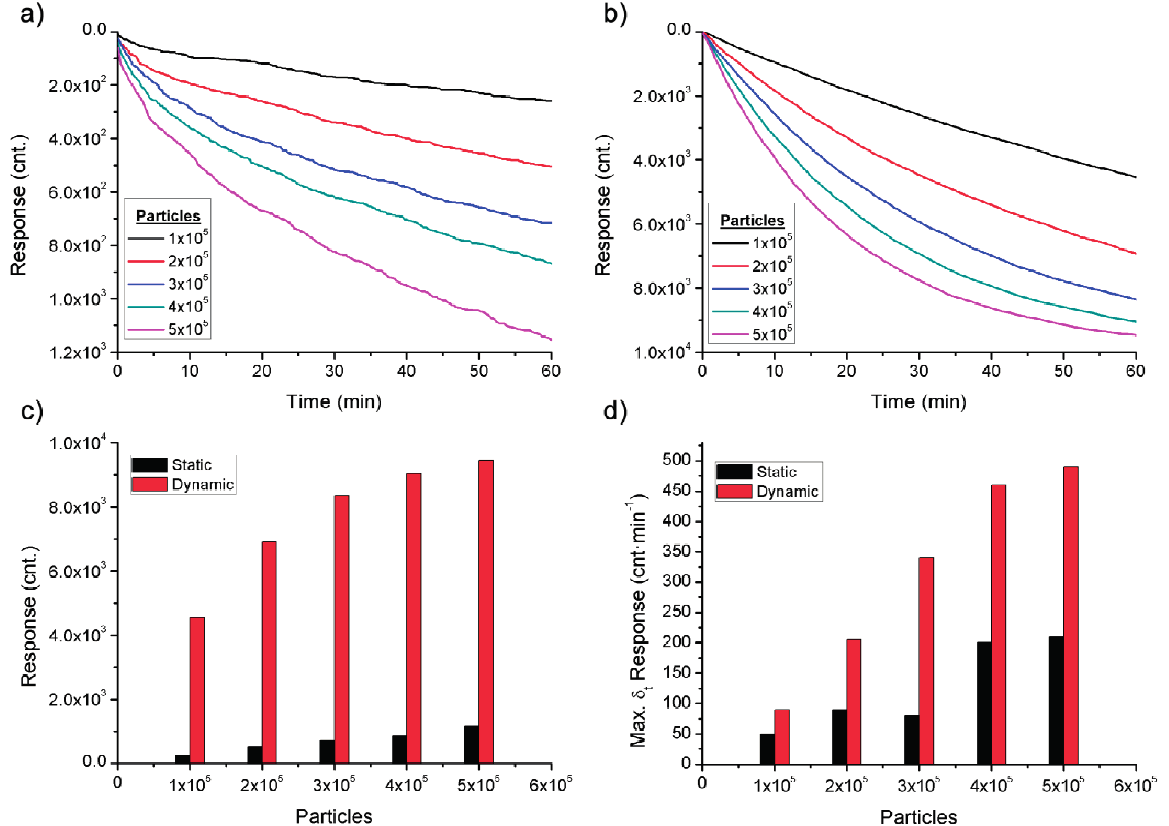
Figure 2. Simulation of ( a ) detection in static mode; ( b ) detection in dynamic mode; ( c ) quantification of the concentration by the absolute value of the sensor response after 60 min; and ( d ) quantification of the concentration taking the maximum value of the sensor response per